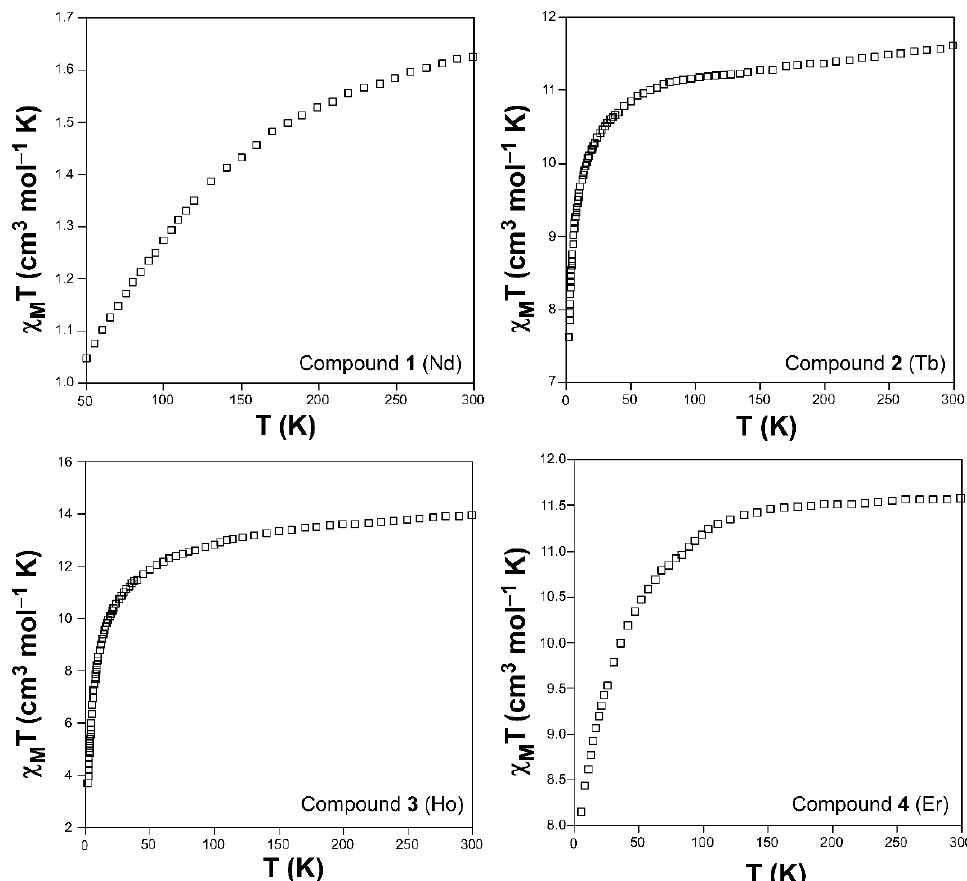
Figure 4. χ M T vs. T plots for all compounds. Codes for each curve are displayed as an inset.